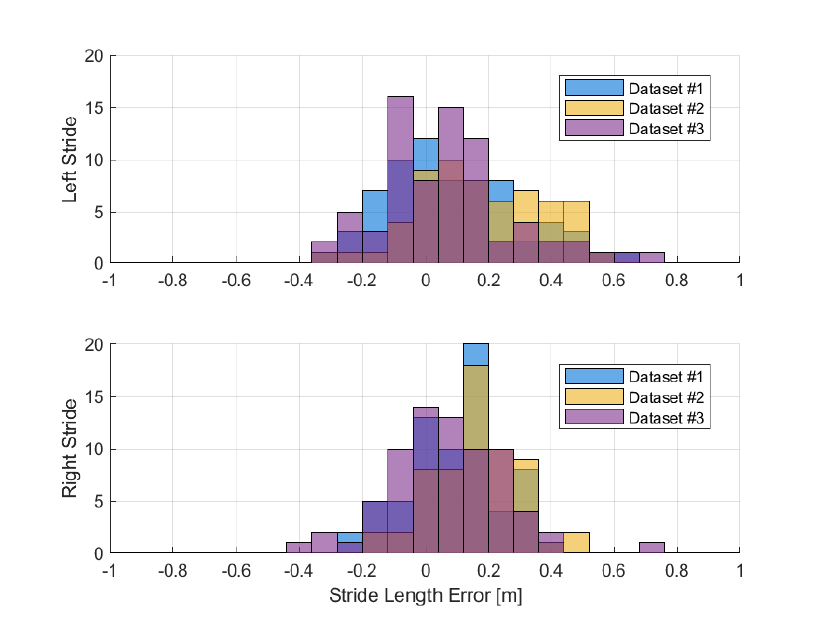
Figure 17. Right foot position trajectory during a swing.